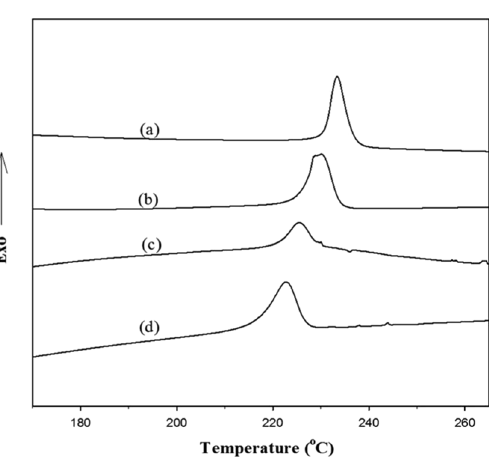
Fig. 4 DSC Tc of a nylon 6/6, b 10 wt% ZnO/nylon 6/6, c 20 wt% ZnO/nylon 6/6 and d 30 wt% ZnO/nylon